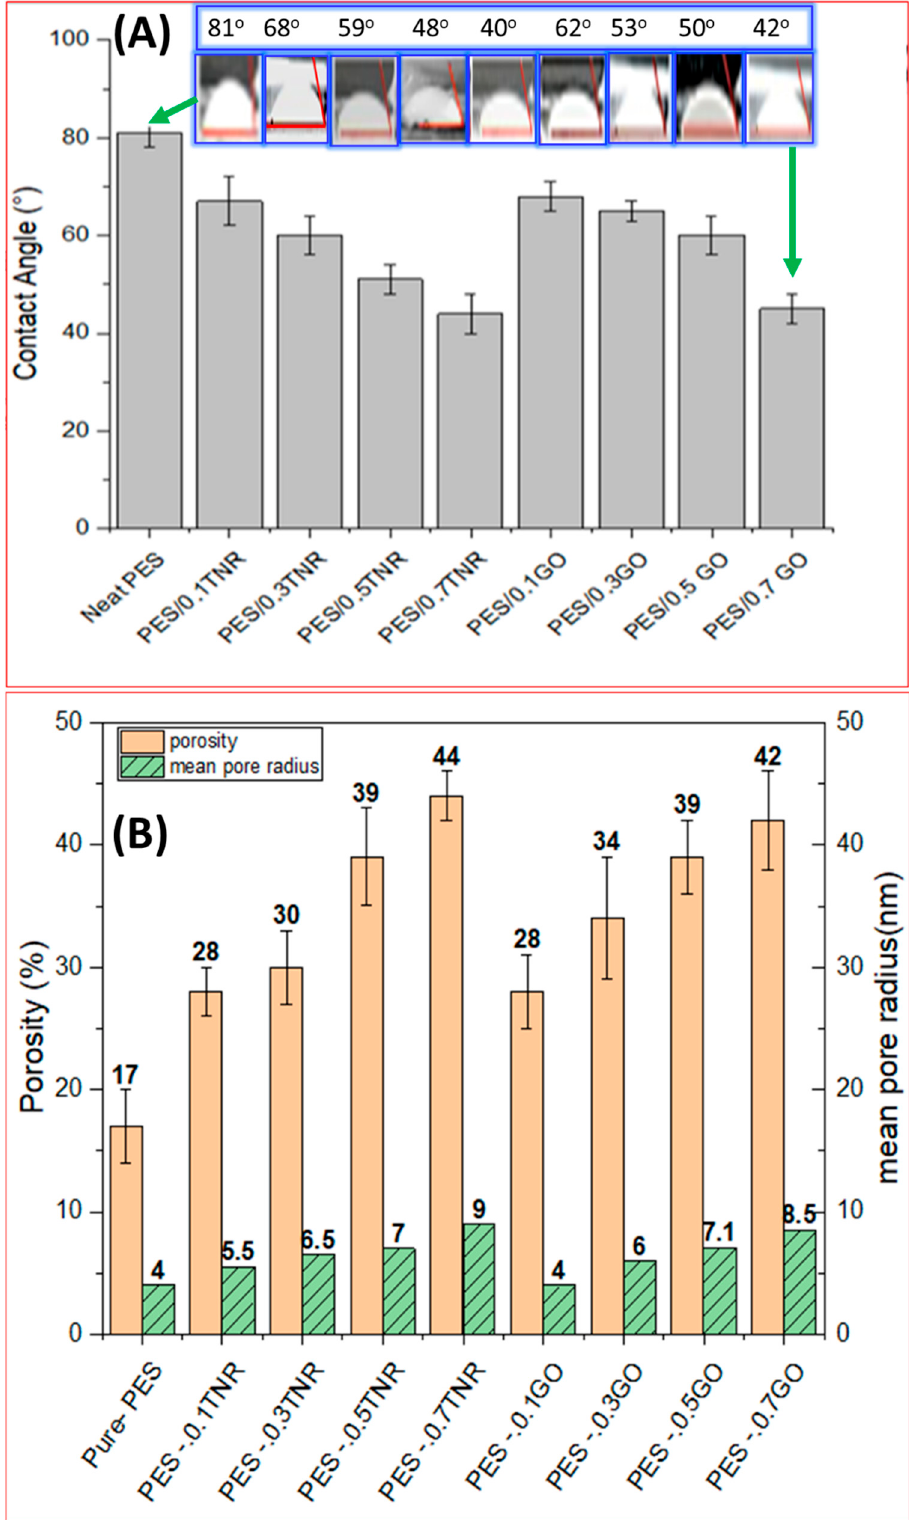
Figure 1. ( A ) Contact angle and ( B ) porosity and mean pore radius of the synthesized membranes.